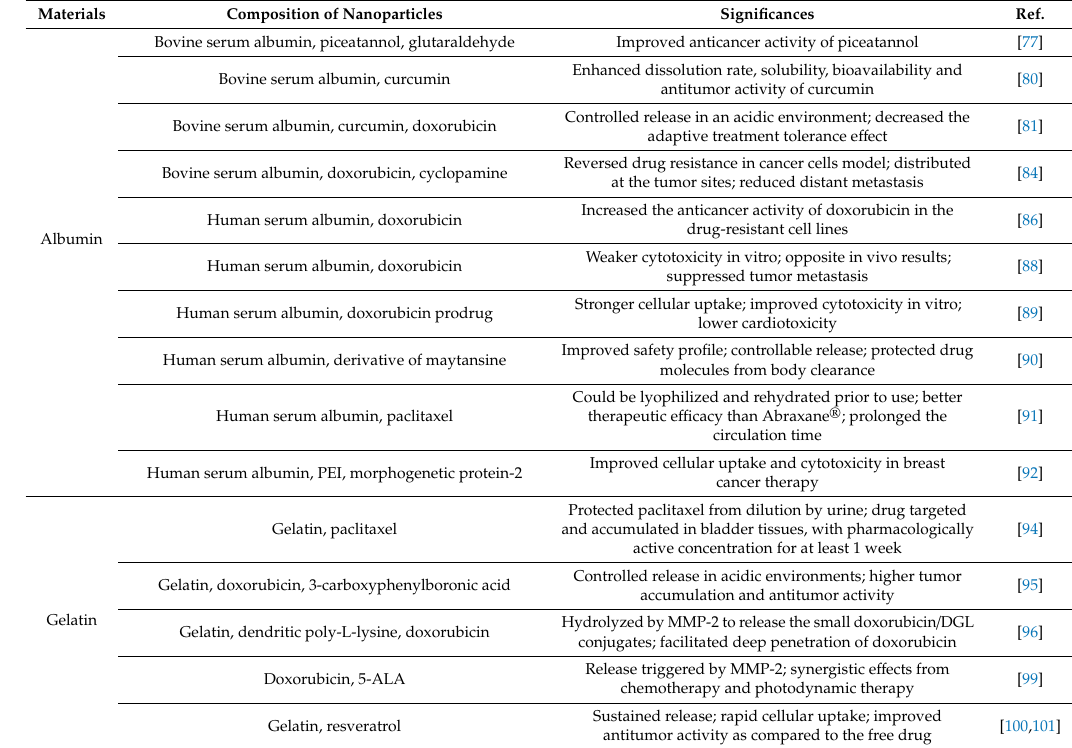
Table 2. Examples of protein-based